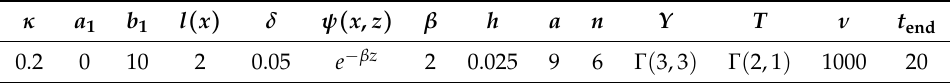
Table 3. Set of parameters used in the second